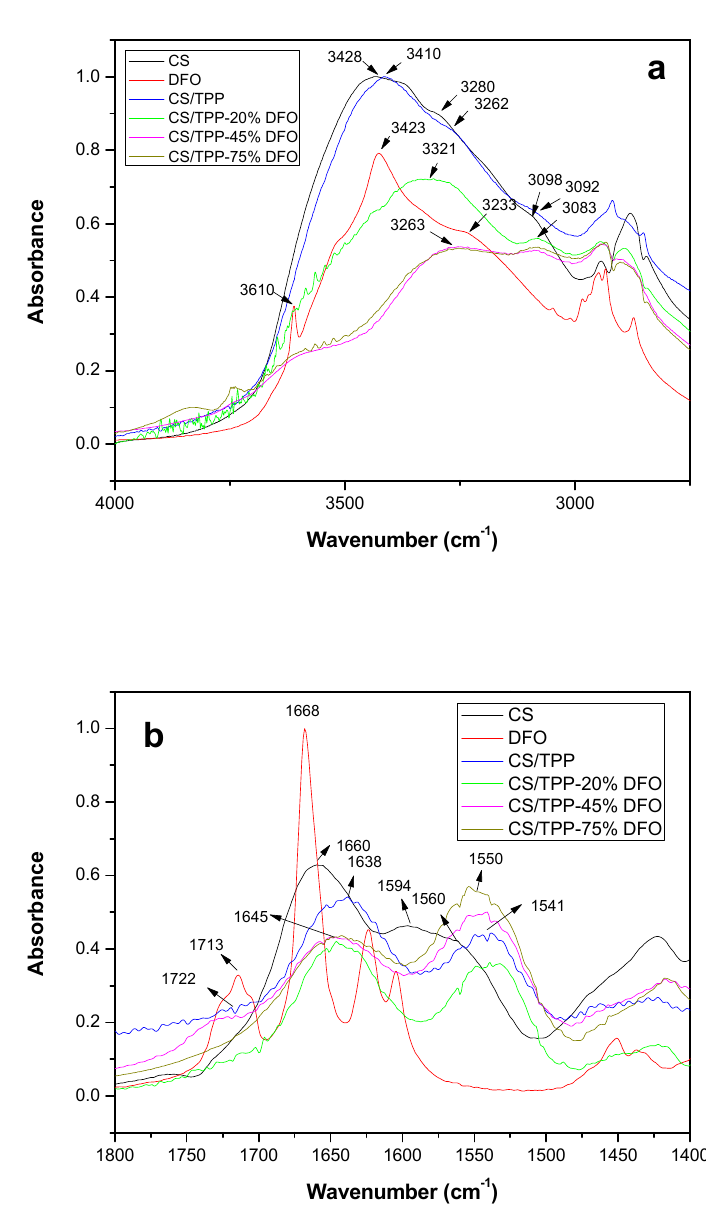
Figure 5. FTIR spectra of CS, DFO, CS/TPP and their nanoparticles containing different amounts of DFO in the areas of ( a ) of hydroxyl groups absorption and ( b ) carbonyl groups absorption.